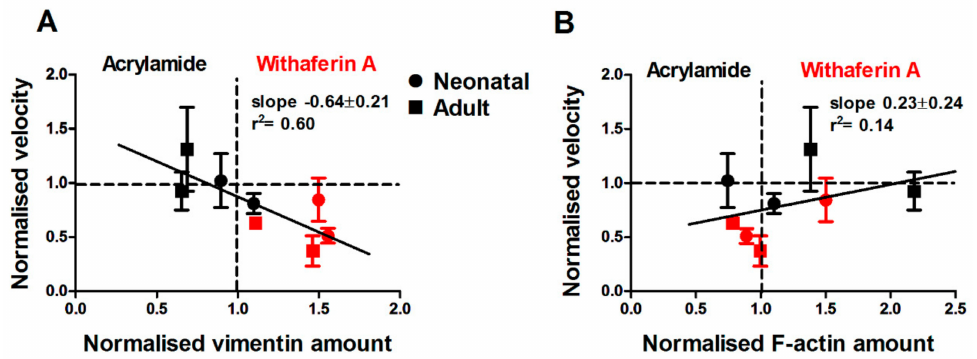
Figure5. AcrylamideandwithaferinAtreatmentshaveareversablee ff ectondermalfibroblastmigration and vimentin and actin fibres. ( A ) Corresponding plot showing the increased cell velocity of cells treated with acrylamide and decreased cell velosity of cells treated with withaferin A, which correlated with changed in vimentin amount. ( B ) The plot shows that cell velocity was not correlated to changes of F-actin amunt. Plots are presented using acrylamide 4 and 6 mM, and withaferin A 2.5 and 5 µ M concentrations. The data of all concentrations are presented in Supplementary Figures S6 and